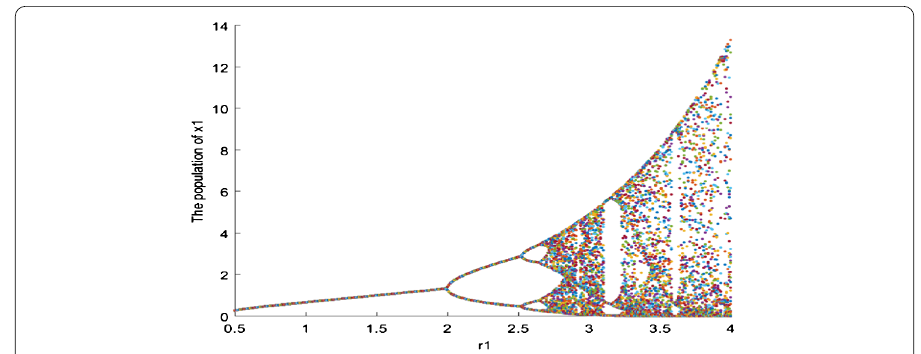
Figure 3 The flip bifurcation of the first component of the solution ( x 1 ( n ), x 2 ( n )) of system (4.1) with initial condition ( x (0), y (0)) = (0.14,0.19).